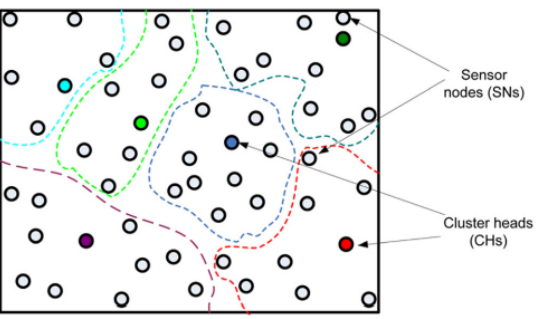
Figure 2. Cluster-based WSN (each cluster is depicted in a distinct